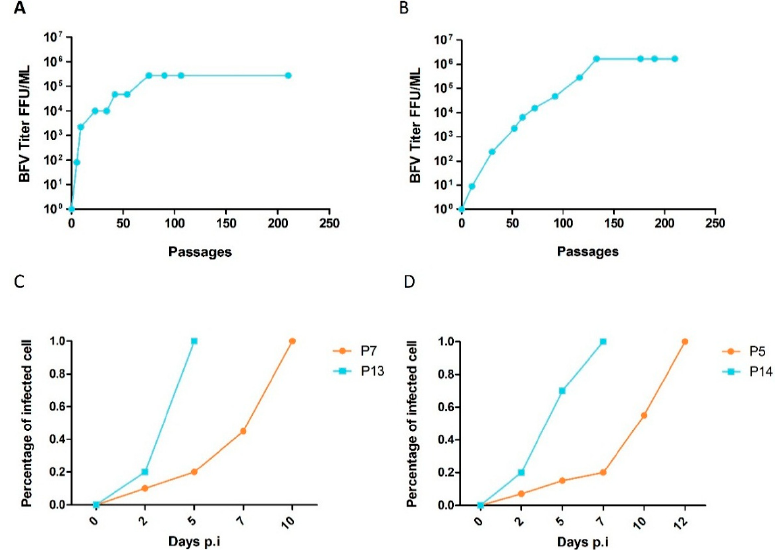
Figure 5. Kinetics of adaptation of cell-free infectious BFV in MDBK and BHK-21 cultures. Cell-free infectivity of selected BFV was monitored during serial passaging. (A-B) Culture supernatants from serially passaged BFV-infected ( A ) MDBK and ( B ) BHK-21 cells were filtered and titrated on MICL and BICL cells, respectively. Titers are expressed as focus-forming units per ml (FFU/ml). (C,D) Percentages of BFV Gag-positive cells as determined by IIF for early passages (P) of BFV from ( C ) MDBK and ( D ) BHK-21 cells were determined at different time points. BFV-infected MDBK cells: P7 and P13; BFV-infected BHK-21 cells: P5 and